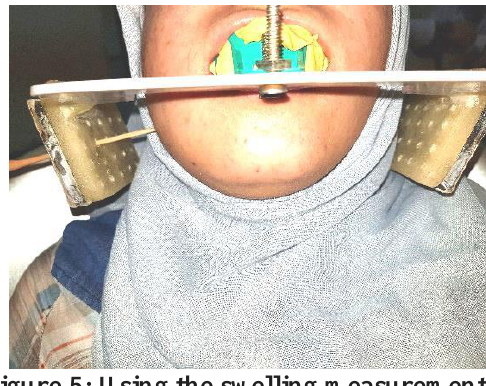
Figure 5: Using the swelling measurement device at 1 st follow up